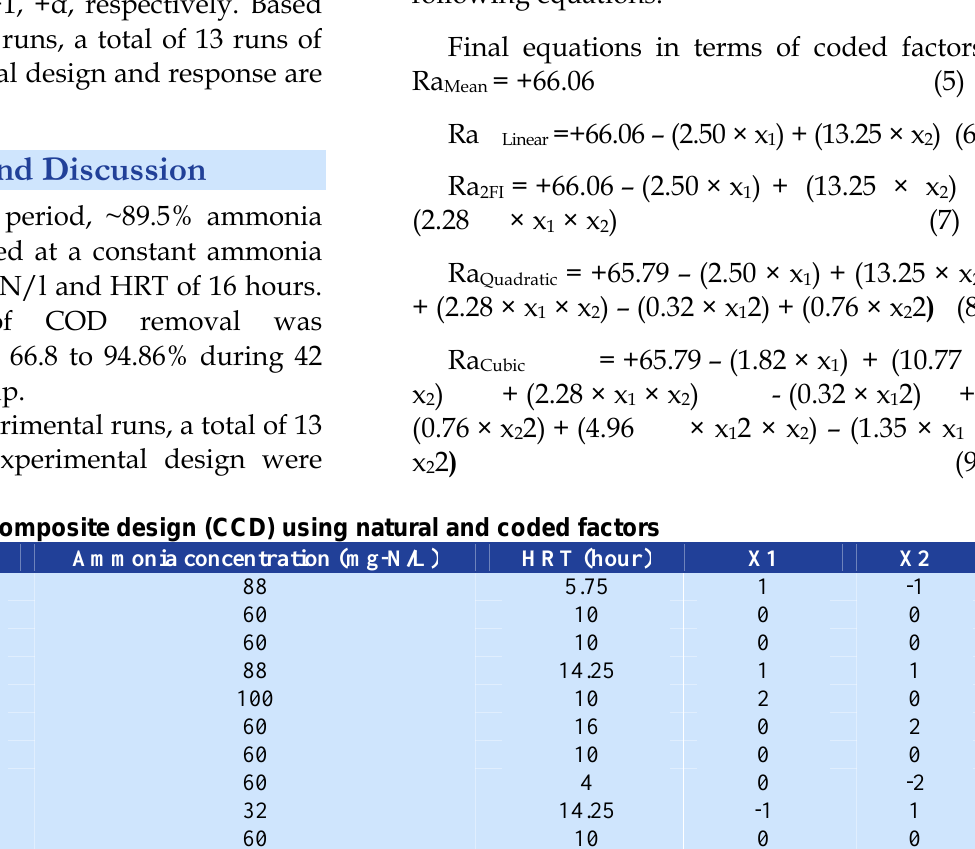
following equations.